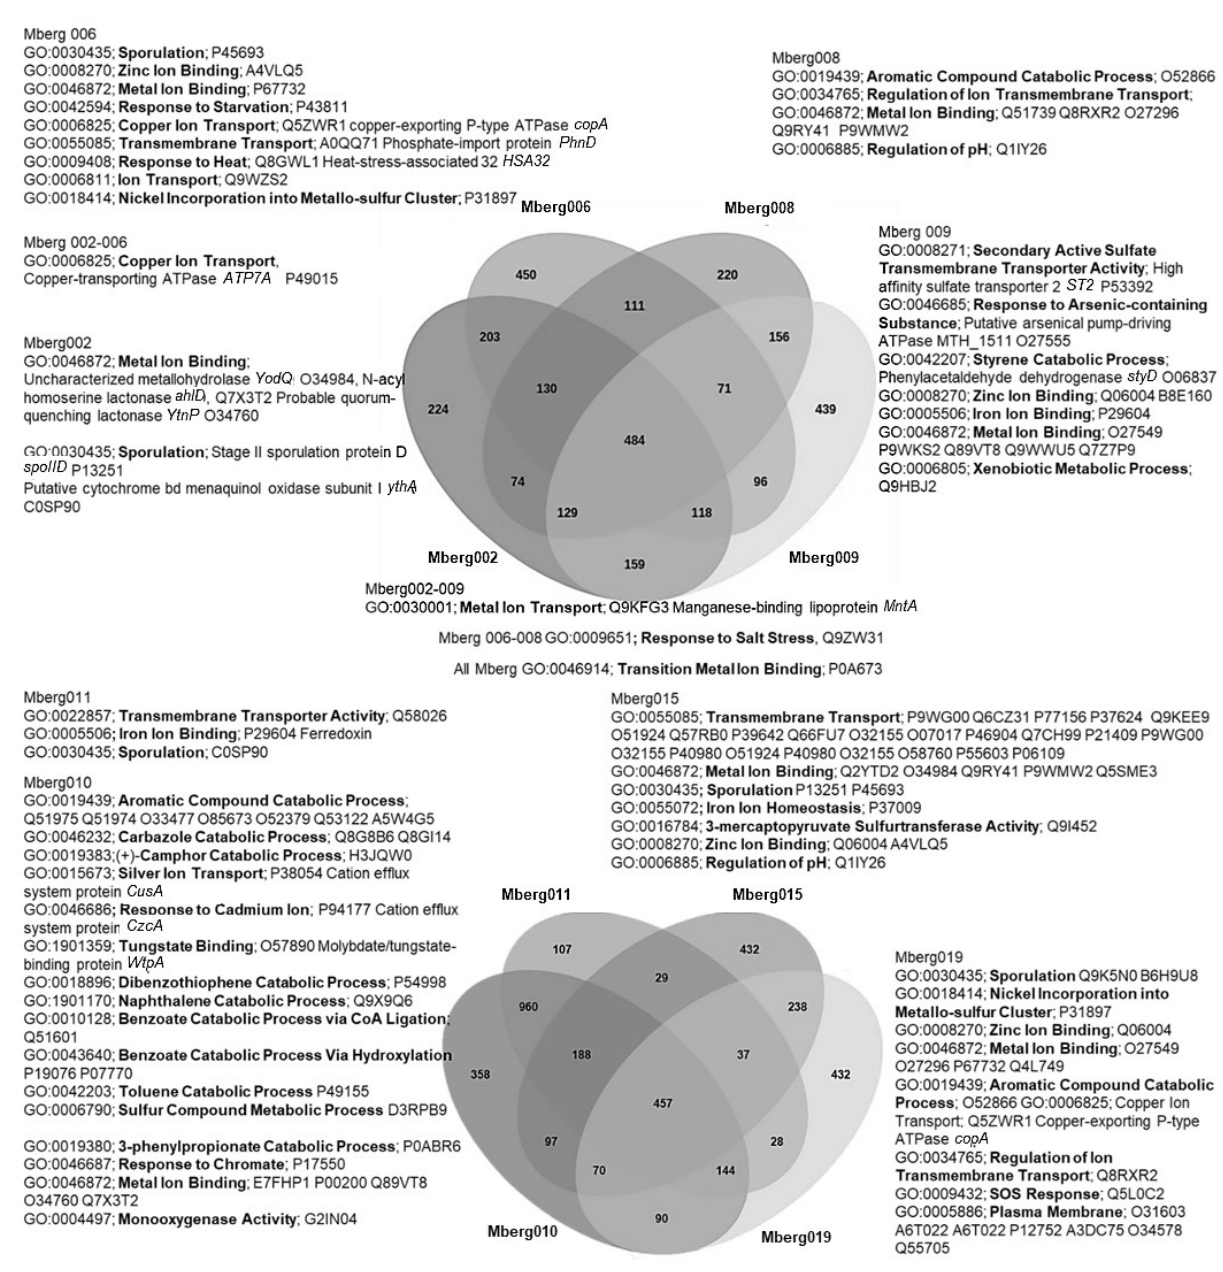
Figure 7. Venn diagram displaying the distribution of shared orthologous clusters among the eight assembled genomes. The orthologous clusters of similar proteins have been allocated the GO terms based on same function or process. Only the GO terms related to metals, aromatic compound, sporulation, and pH regulations are mentioned to identify the microbial survival under extreme stress conditions. The closely matched proteins are identified as Swiss–Prot accession numbers, and names of some important hits are